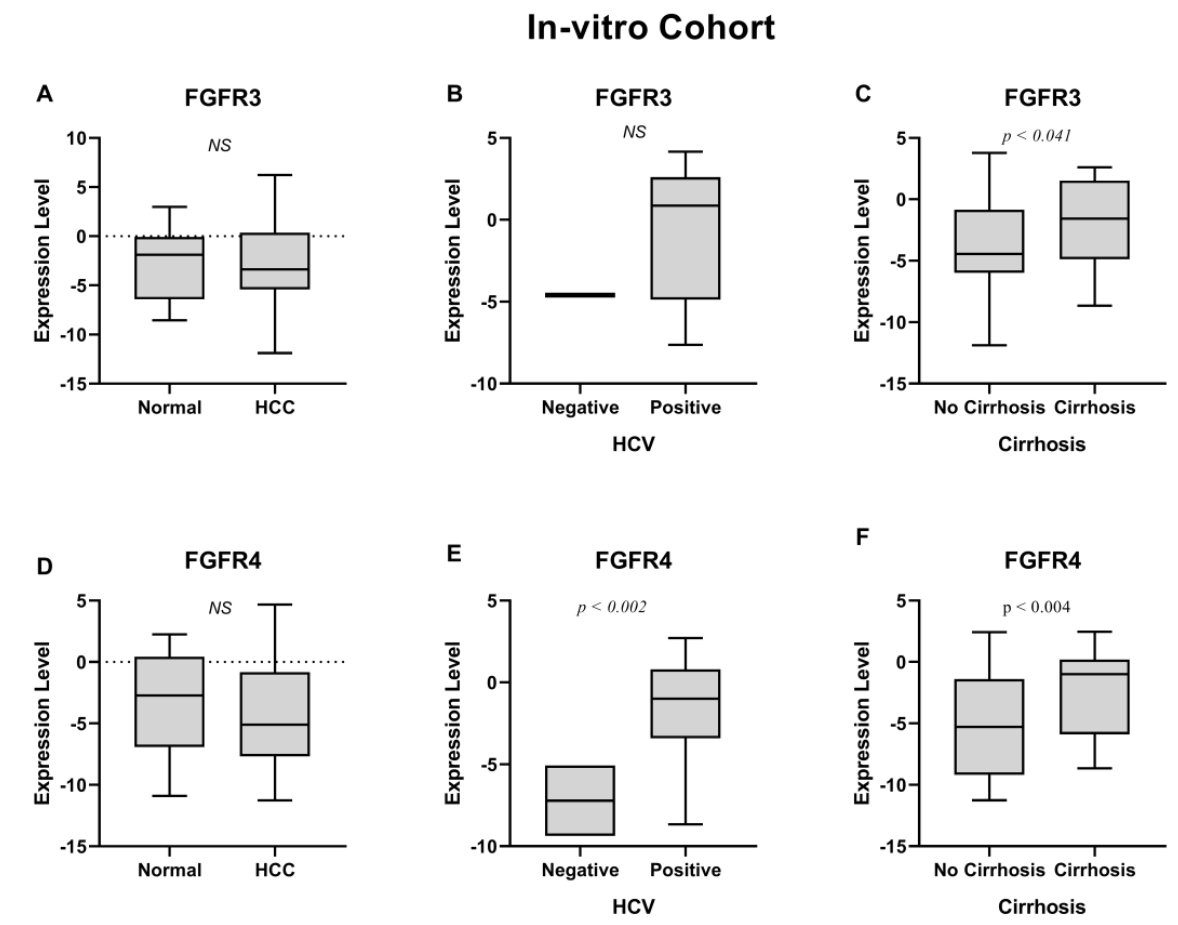
Figure 2. ( A ) FGFR3 expression in HCC shows no significant p -value. ( B ) Regulation of FGFR3 in HCV+ patients shows no significant p -value. ( C ) FGFR3 is upregulated in cirrhosis. ( D ) FGFR4 expression in HCC shows no significant p -value. ( E ) FGFR4 upregulation in HCV+ patients. ( F ) Upregulation of FGFR4 in